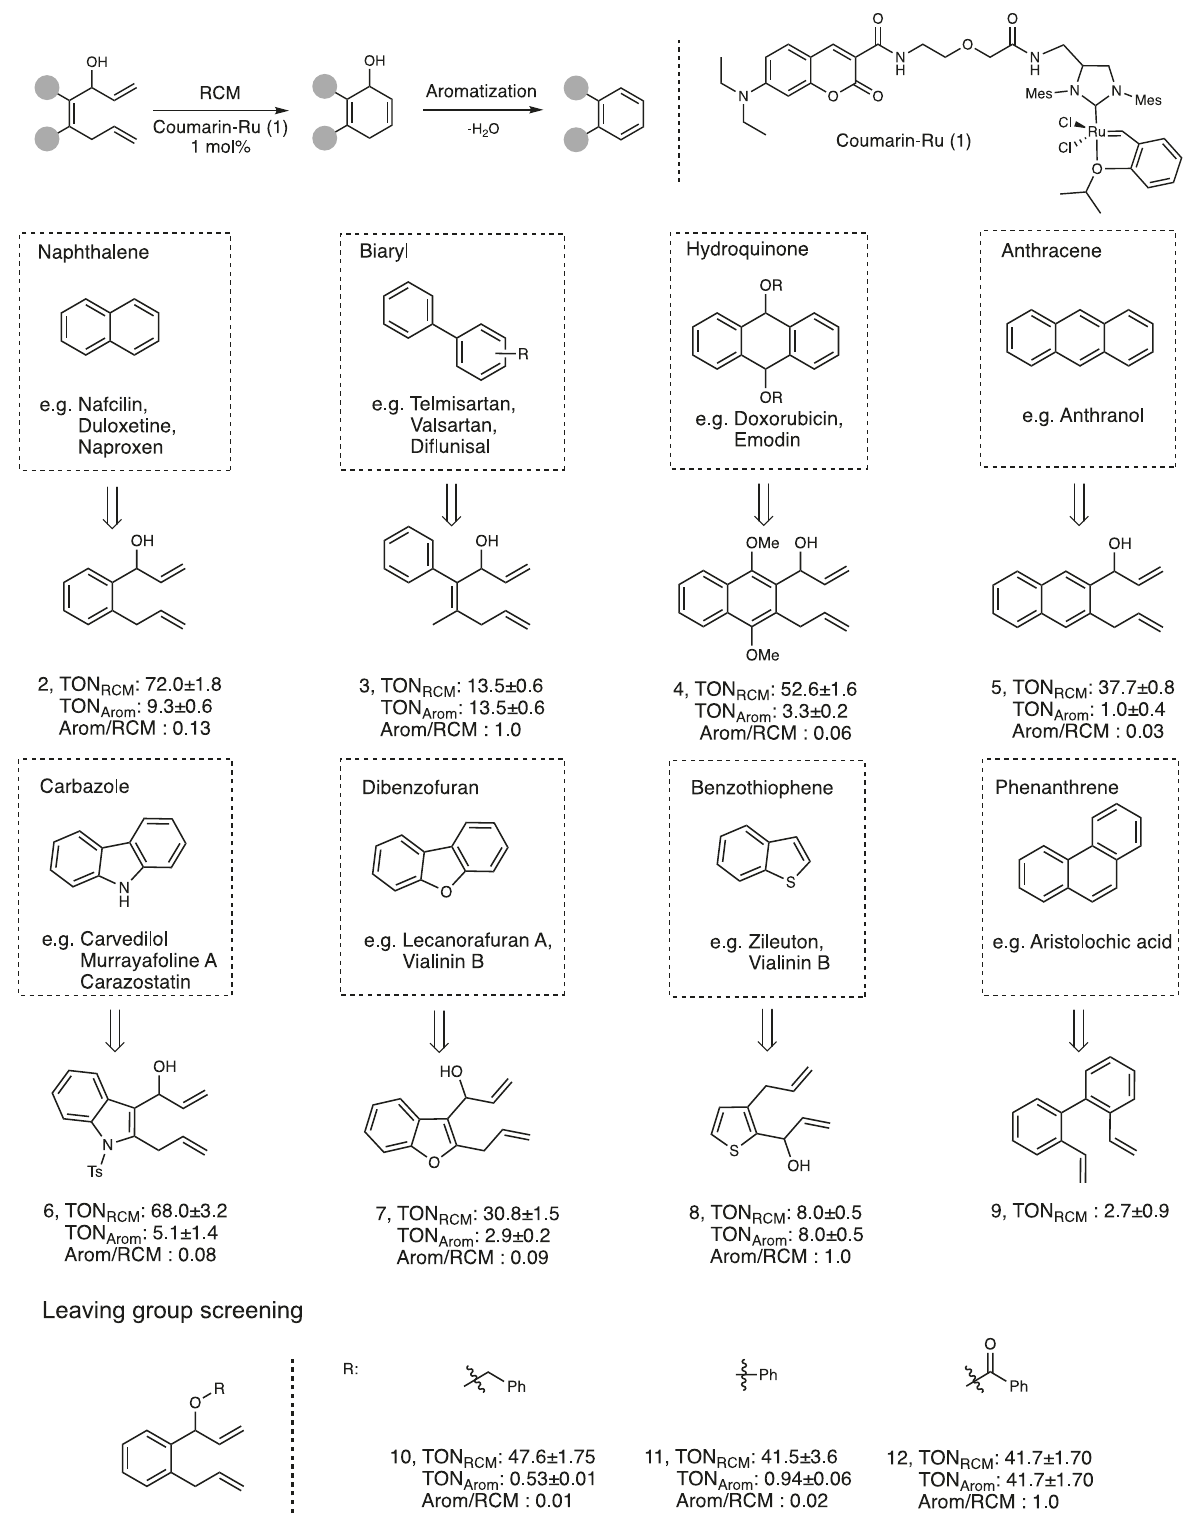
Fig. 2 Model substrates for various pharmacophore fragments. All reactions were carried out under the standardized conditions: 4 mM of substrate was incubated with 1 mol% of ruthenium catalyst 1 in PBS/1,4-dioxane (9:1) for 2 h at 37 °C. TON values were determined from product yields obtained by HPLC analysis; where TON Arom refers to fi nal product and TON RCM refers to the combination of cyclohexadien-1-ol intermediate/ fi nal product. TON RCM for compound 11 was calculated based on starting material conversion. Reactions were performed in